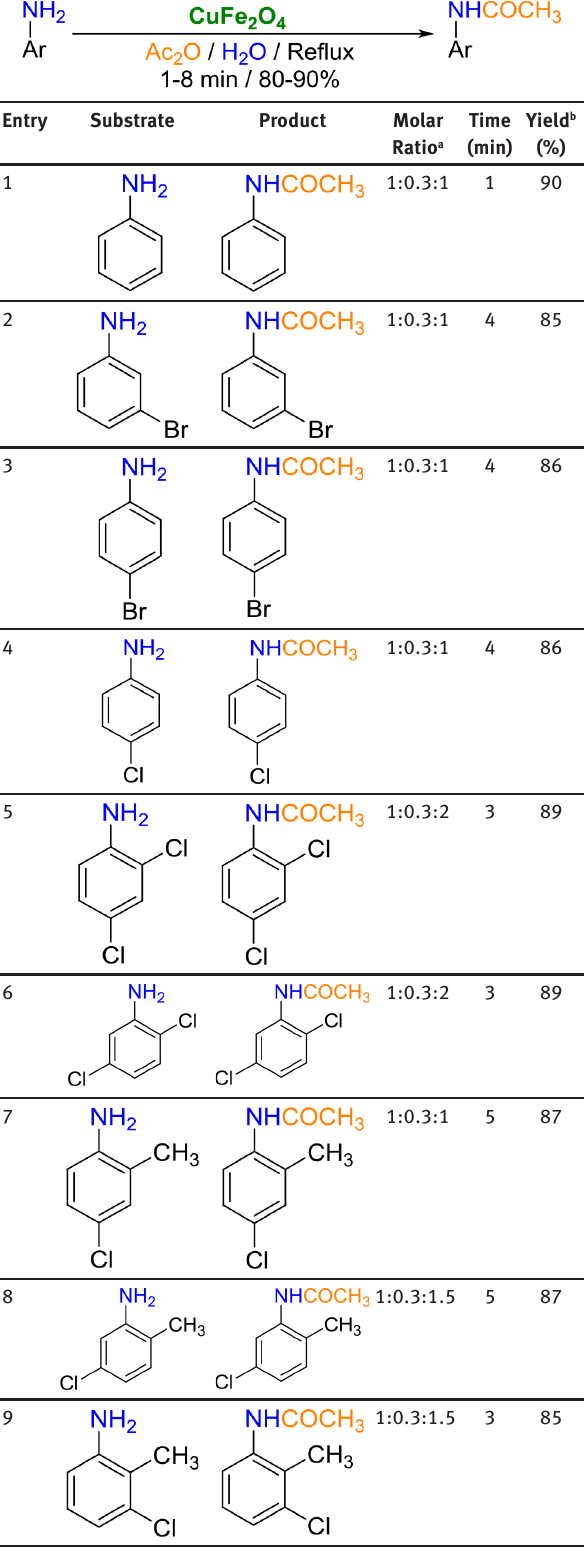
Table 2: N -acetylation of arylamines using Ac